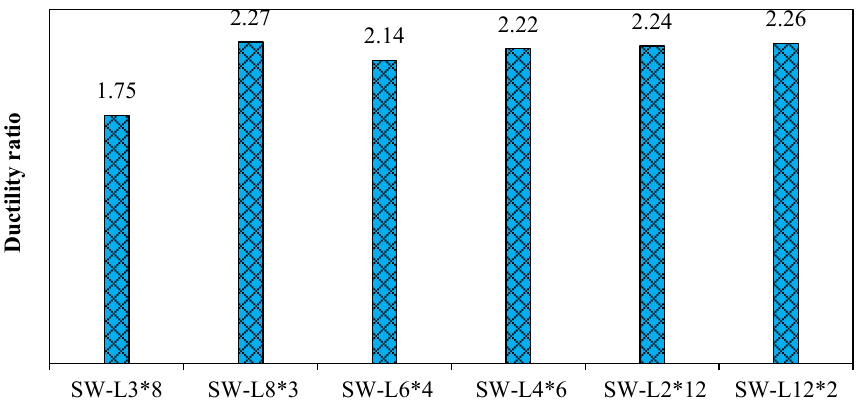
Figure 26. Ductility ratio of group 4.